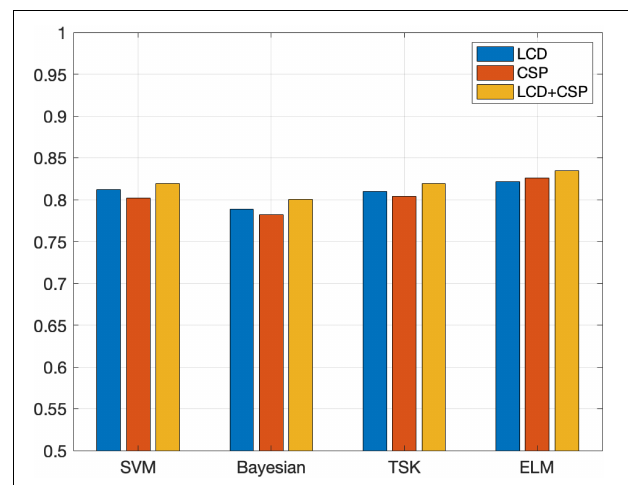
FIGURE 6 | Classification accuracy obtained by each classification model on the Data Sets IIIa.